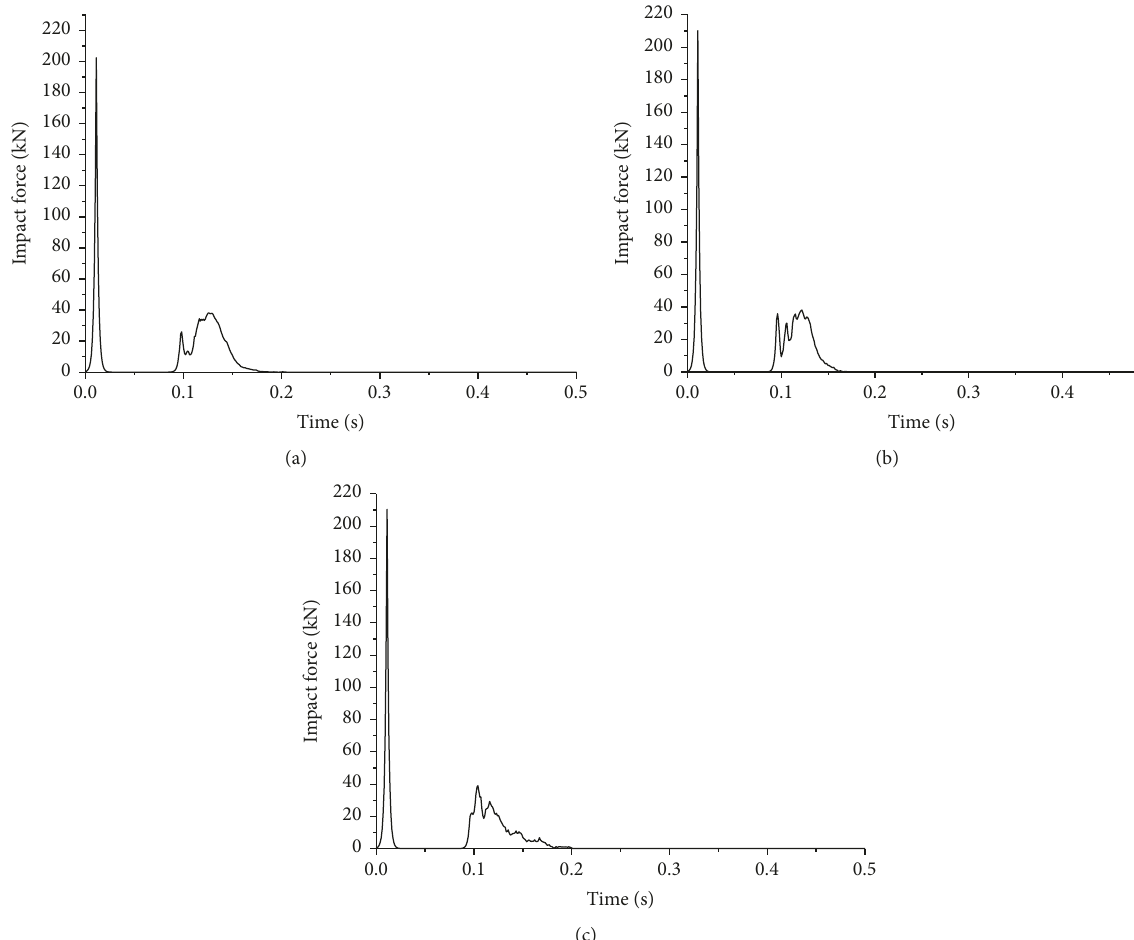
Figure 13: Impact time history curves: (a) model 4, (b) model 5, and (c) model 6.